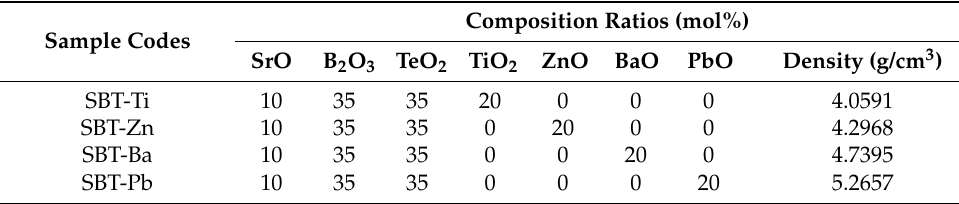
Table 1. The composition and density of the prepared